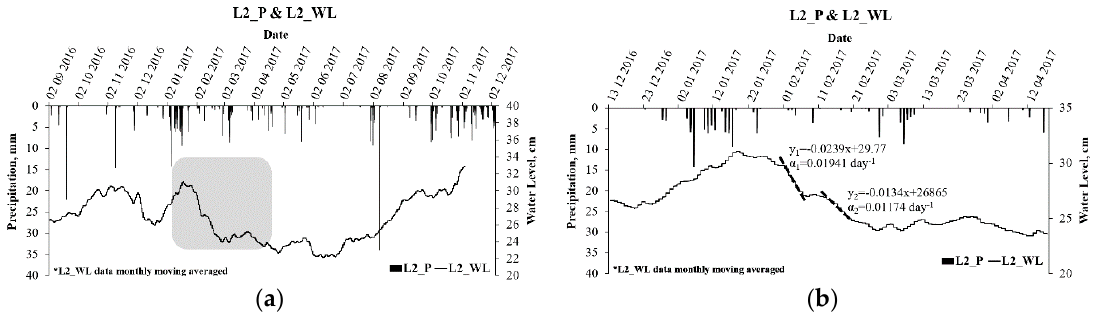
Figure 11. ( a ) The period (grey area) where the recession coefficients for the L2_WL data were calculated in; ( b ) two different recession coefficients were calculated for L2_WL data.